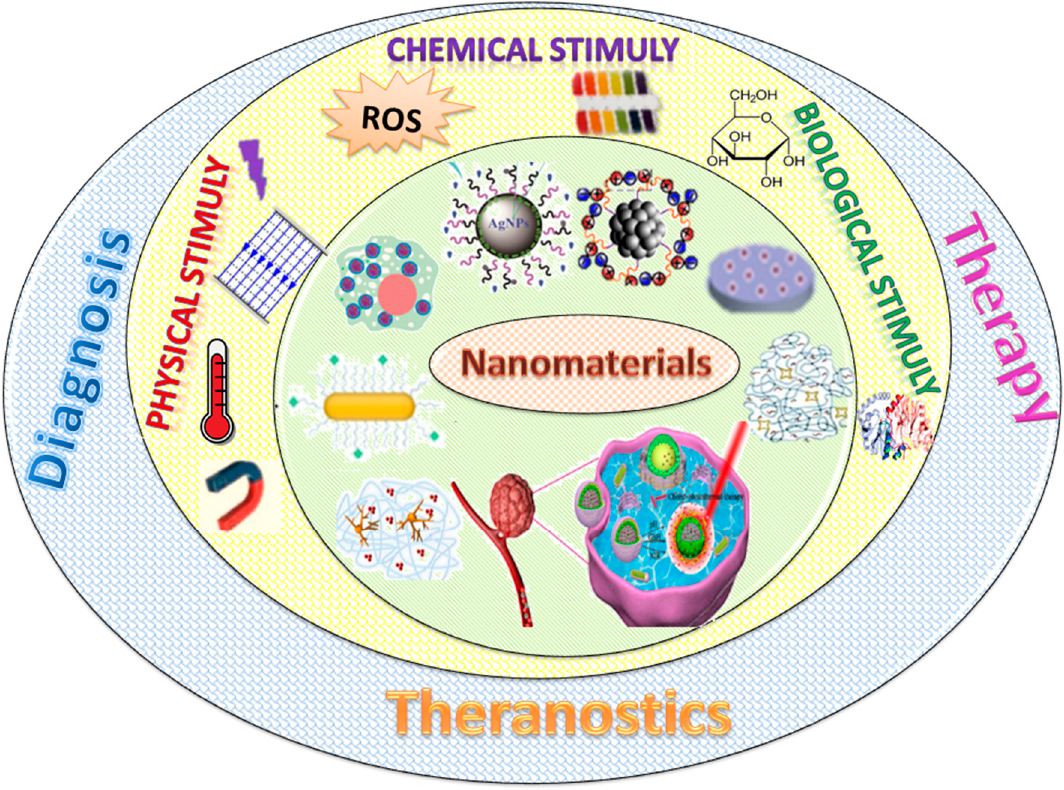
Figure 1. Classification and biomedical applications of smart nanomaterials as a function of their nanostructure. Table 1. Examples of physico-responsive nanomaterials and their biomedical applications. Nr. Crt.